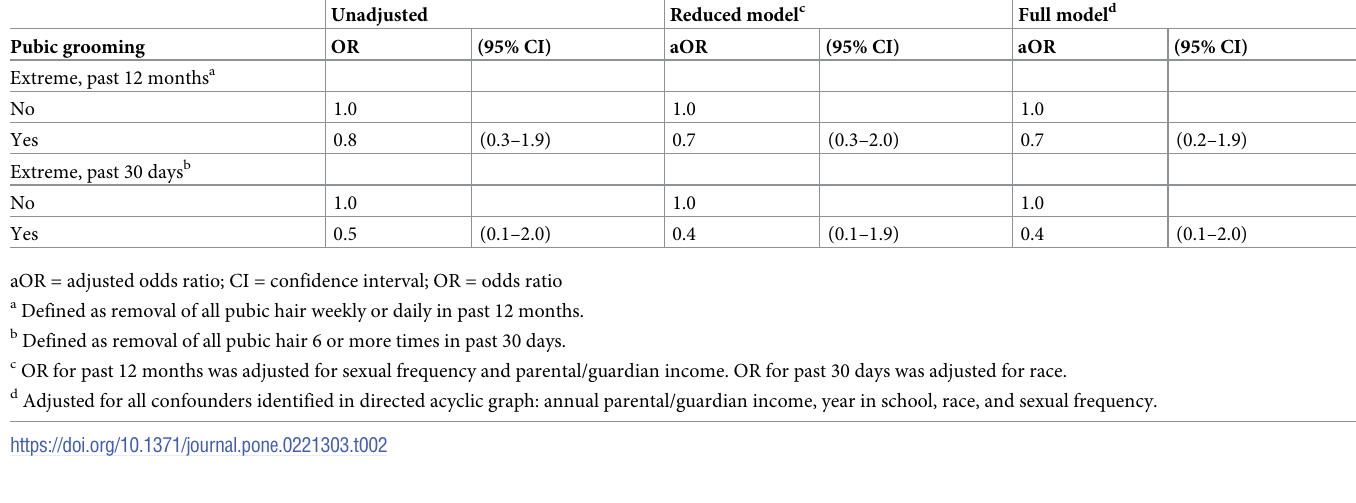
Table 2. Association between extreme grooming and gonorrhea or chlamydial infection among female university students attending for sexually transmitted infec- tion testing (n = 214).